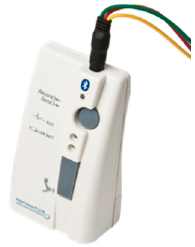
Figure 2. HearthView P-12/8 is a portable electrocardiograph capable of recording 12-leads electrocardiogram (ECG).